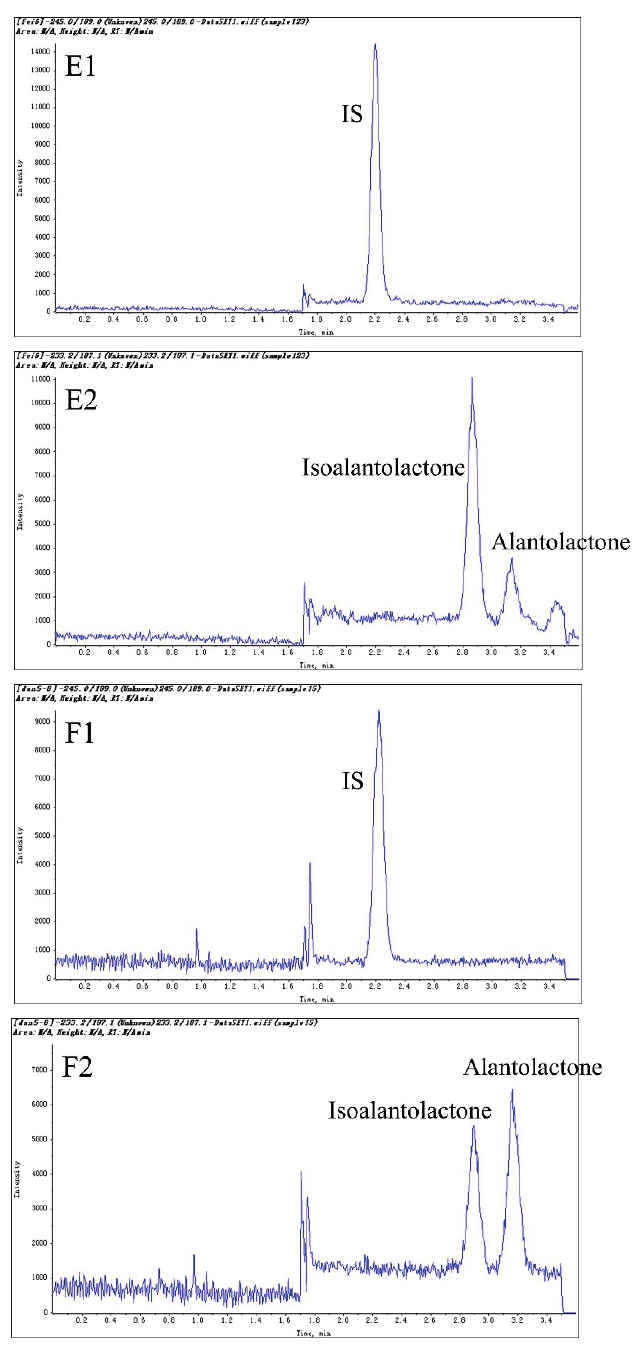
Figure 2. Representative multiple reaction monitoring chromatograms of ( A ) a blank plasma sample of rats; ( B ) a plasma spiked with 2 ng/mL isoalantolactone, 4 ng/mL isoalantolactone (LLOQ) and IS (0.5 ng/mL); ( C ) a blank rat liver sample of rats; ( D ) a blank rat urine sample spiked with isoalantolactone (25 ng/mL), alantolactone (25 ng/mL) and IS (0.5 ng/mL); ( E ) a rat lung sample with IS at 12 h after oral administration of Radix Inulae extract (containing 7.06 ng/mL isoalantolactone and alantolactone with concentration under LLOQ) and ( F ) a rat bile sample with IS between 5 and 8 h after oral administration of Radix Inulae extract (containing 507.65 ng/mL isoalantolactone and 899.85 ng/mL